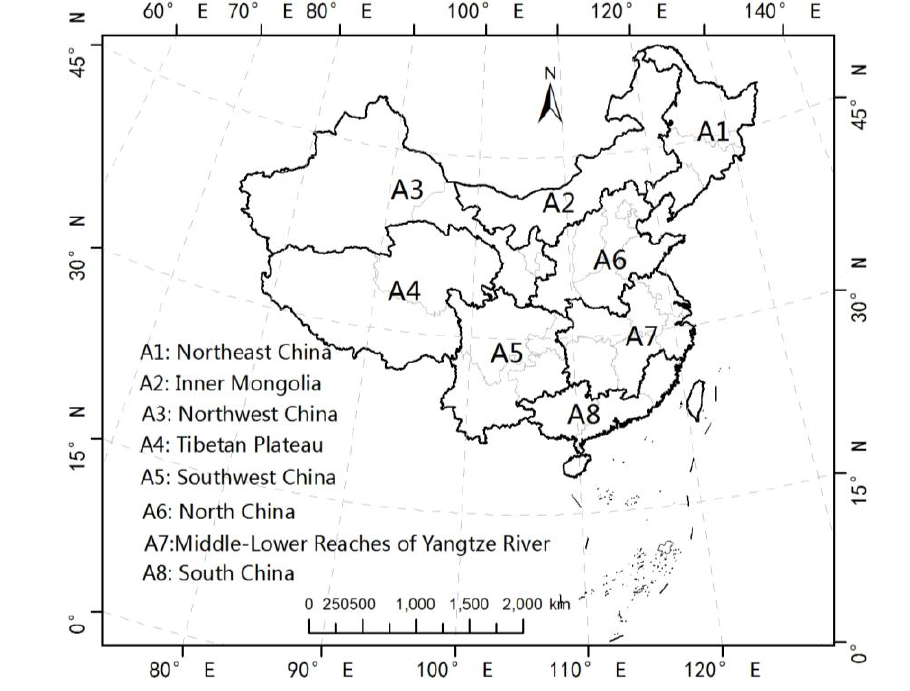
Figure 1. Spatial distribution of regions A1–A8 in China (Taiwan Island and Hainan Island belong to